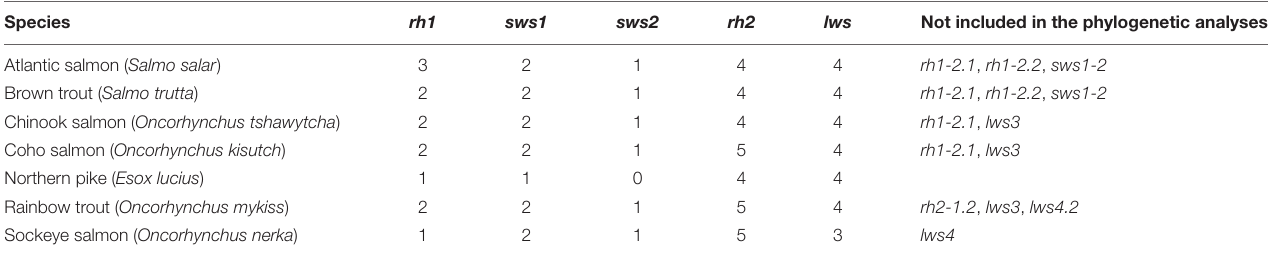
Table 2 ). Phylogenetically, rh2-1/rh2-2 and rh2-3/rh2-4 appear to branch together.